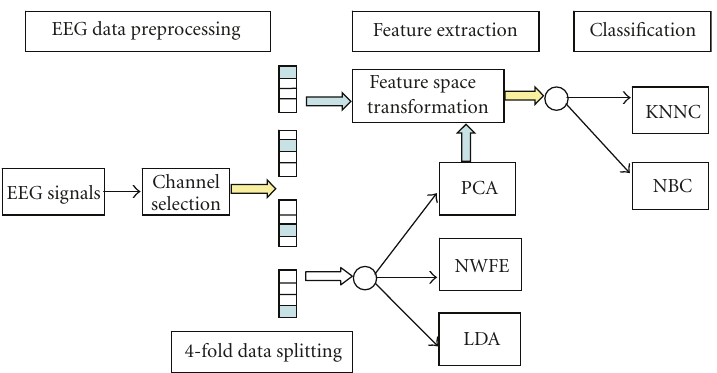
Figure 2: System flowchart for processing the EEG